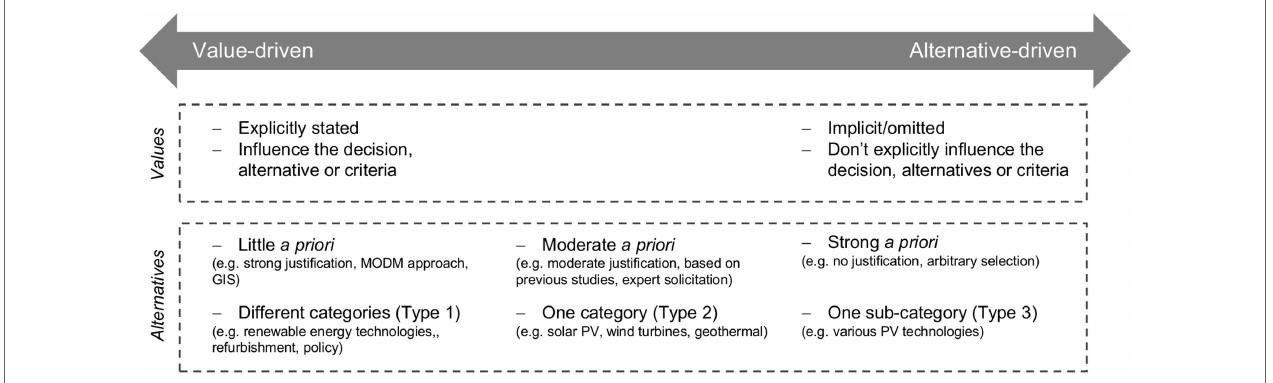
FiGURe 4 | Considered characteristics for classifying the studies as value or alternative driven